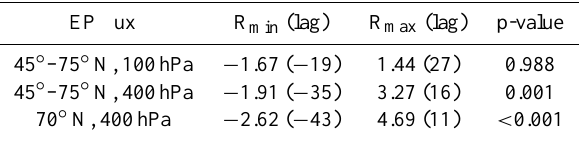
Table 1. Minimum and maximum lagged regression between the 60-day low-passed vertical EP flux anomalies and the 60-day low- passed normalized NAM index at 20hPa [10 4 kgm − 1 s − 2 ], lag in days, and p-values for the one-side paired difference t -test with the null hypothesis H 0 : | R max |−| R min | ≤ 0. The NCEP-NCAR re-